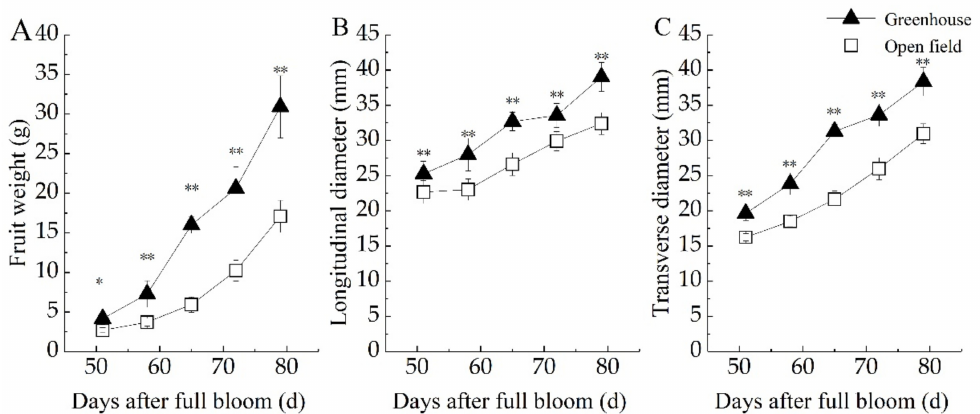
Figure 3. Changes in fruit weight and diameter of bayberry grown in a greenhouse and in the open field. ( A ) Fruits weight during bayberry developmental stages. ( B ) Longitudinal diameter of fruits during bayberry developmental stages. ( C ) Transverse diameter of fruits during bayberry developmental stages. Graphics marked ** are significantly different ( p < 0.01), * is significantly different ( p < 0.05) based on